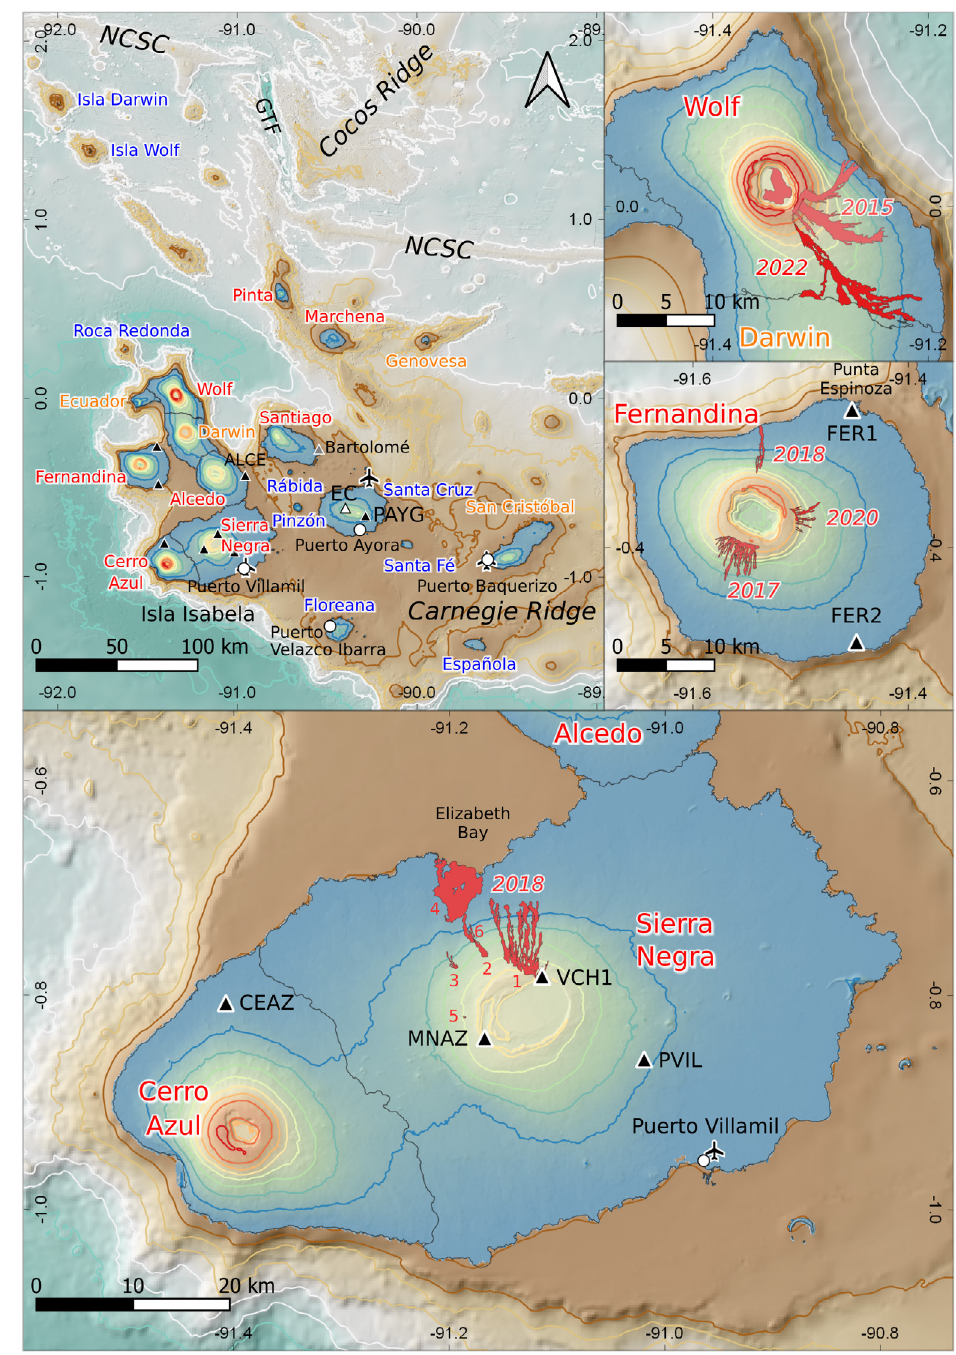
Figure 1: Map of Galápagos archipelago and close-ups of Galápagos volcanoes with eruptions since 2010. The names of the main subaerial volcanoes are in blue (no evidence of Holocene eruptions), orange (evidence of Holocene eruptions) and red (evidence of historical eruptions). Darwin and Ecuador volcanoes are in orange because they lack confirmed historic (since 1797) eruptions but are suspected to have been active in the last 500 years based on their unvegetated lava fields. White dots are for main populations and airplane symbols for airports. New lava fields since 2010 are shown in shades of red on the close-up maps. Numbers in red for the Sierra Negra lava fields correspond to the eruptive fissures. Subaerial contours: 200 m, submarine contours: 500 m. NCSC: Nazca-Cocos Spreading Center; GTF: Galápagos Transform Fault. Black triangles with white outlines show the location of the IG-EPN monitoring stations. PVIL: Puerto Villamil; VCH1: Volcán Chico; MNAZ: Minas de Azufre; CEAZ: Cerro Azul; FER1 and FER2: Fernandina; PAYG: Santa Cruz seismic station; EC: El Chato, Santa Cruz repeater. Coordinate System: WGS